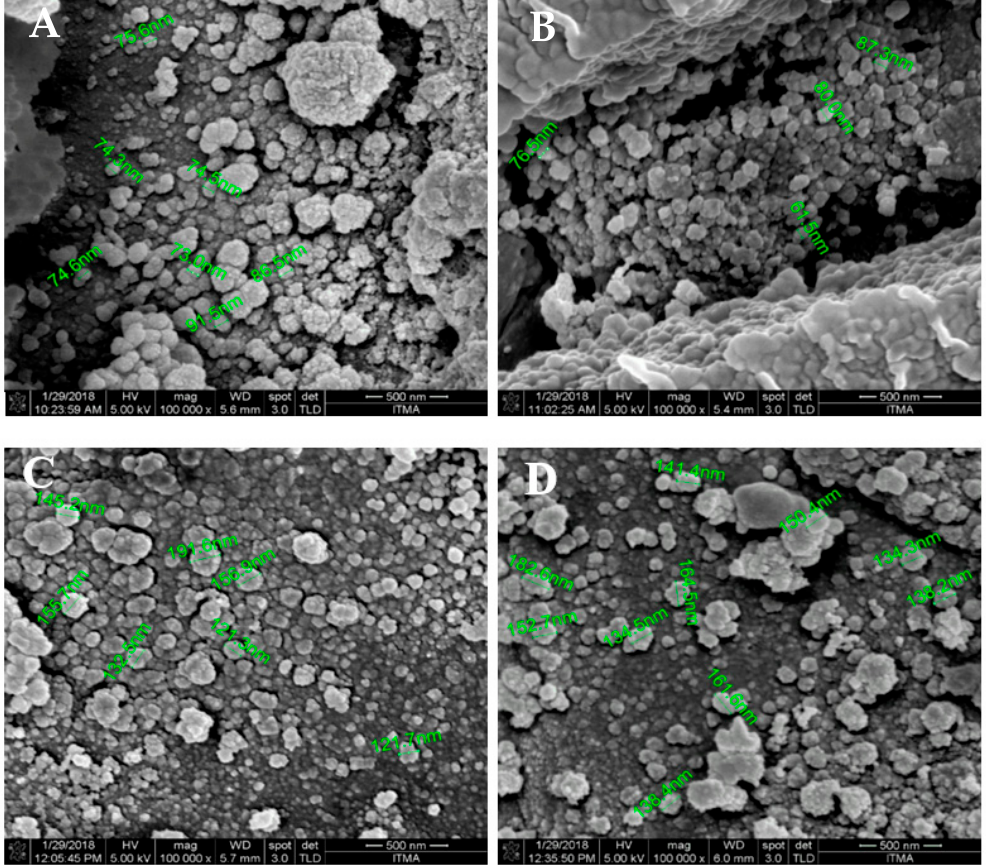
Figure 5. FESEM analysis of nanoparticle samples. ( A ) CNP, ( B ) pCNP, ( C ) CNP-PCA and ( D ) pCNP-PCA. The nanoparticle samples were revealed in single-spherical like particles with uniformed dispersity with different size range.